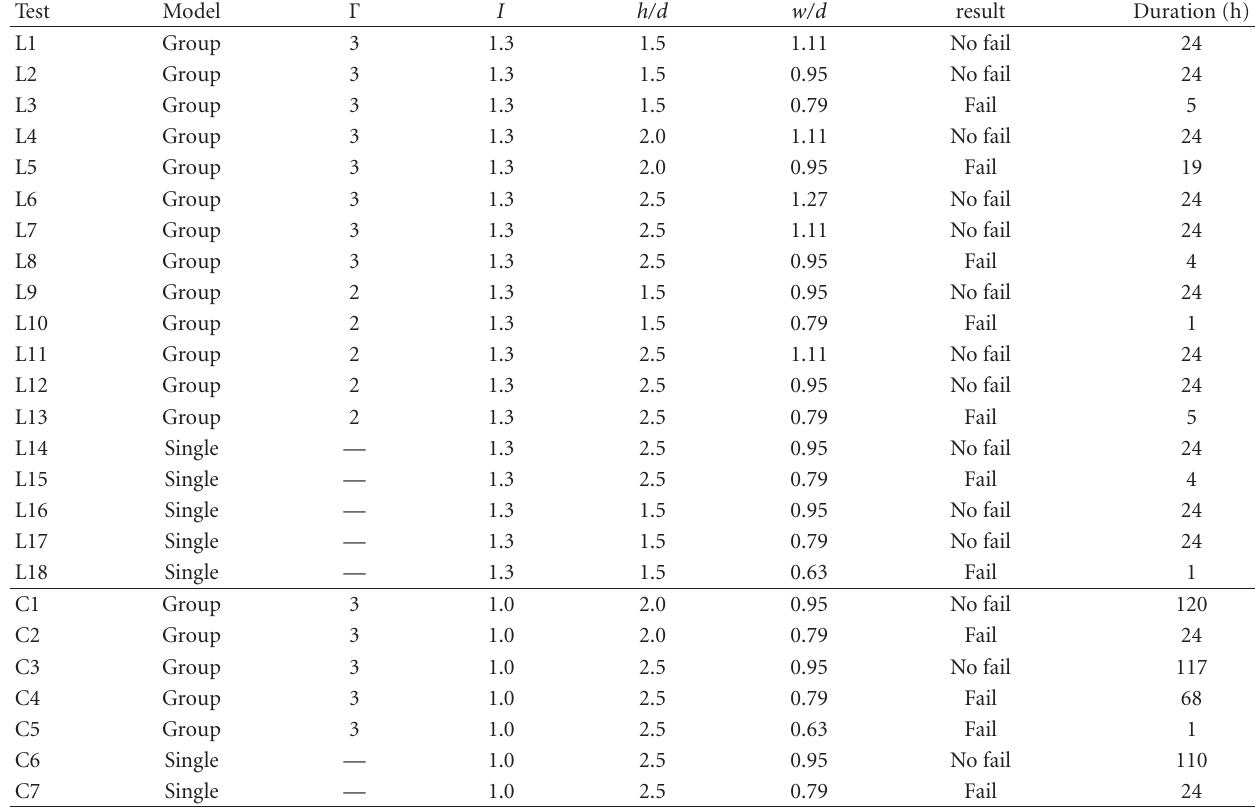
Figure 4: Edge failure test: experimental setup (a) and block dislodgement (b). Table 1: Experimental conditions and results for pile groups and single